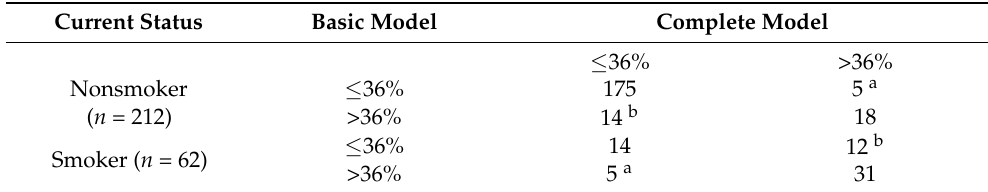
Table 3. Reclassification table of study participants stratified for events (smokers) and nonevents